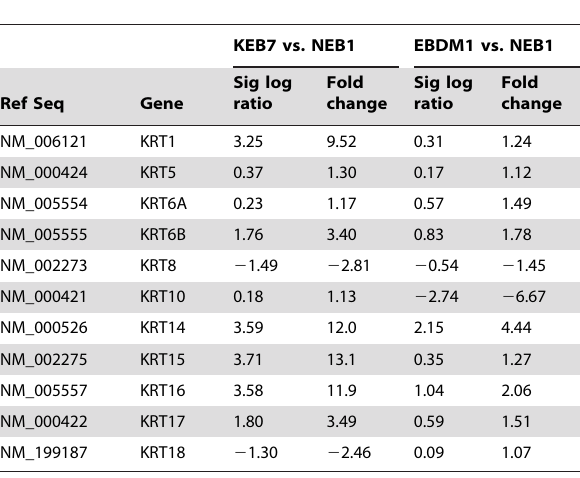
Table 5. Microarray analysis of cytokeratin